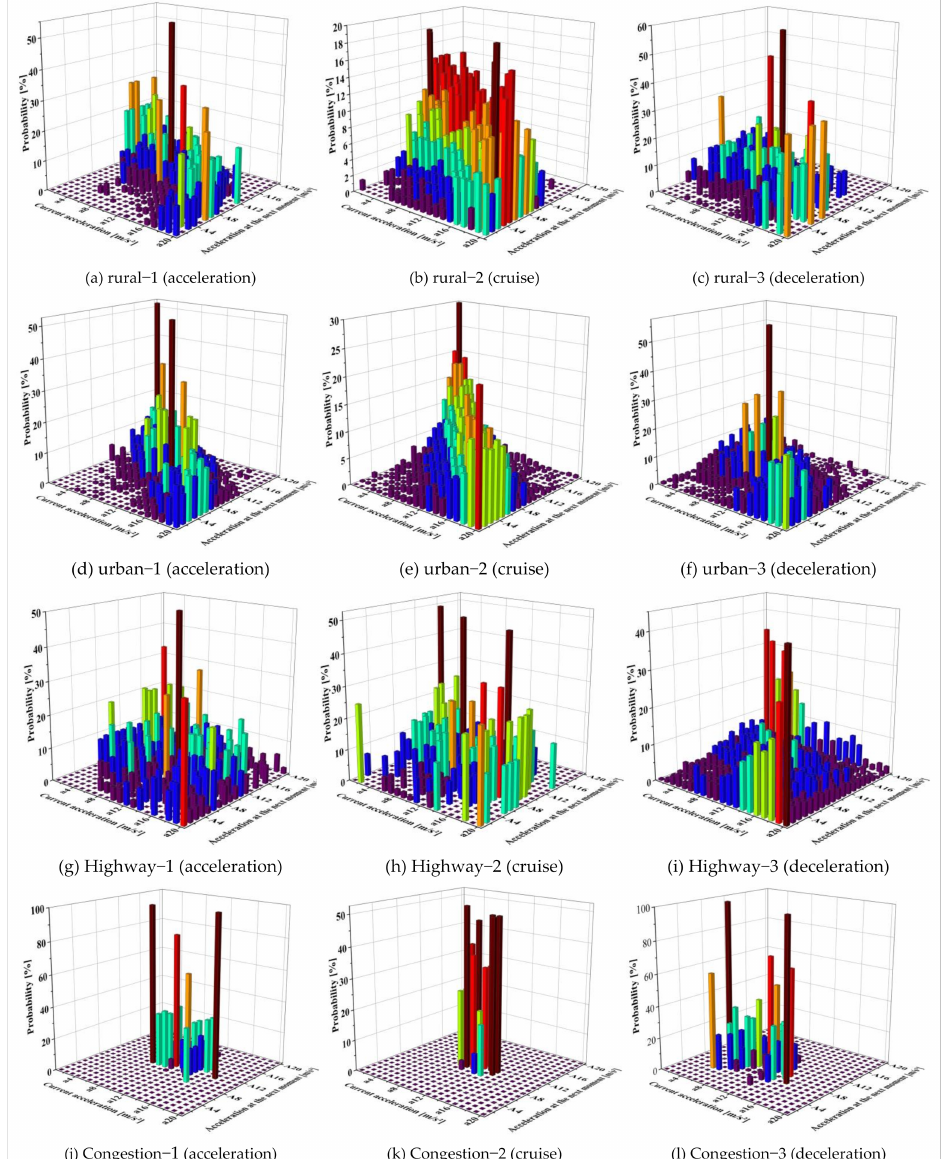
Figure 7. State transition probability matrix of acceleration, deceleration, and